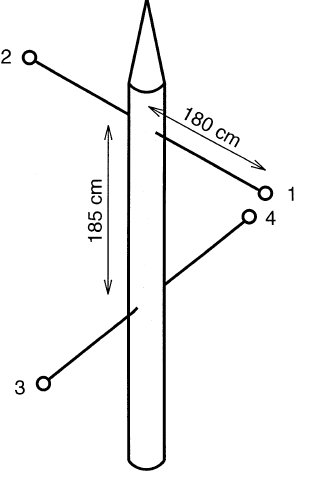
Fig. 2. Probe configuration of a rocket from the ROSE campaign. A more detailed figure describing the rocket is given by Rose et al